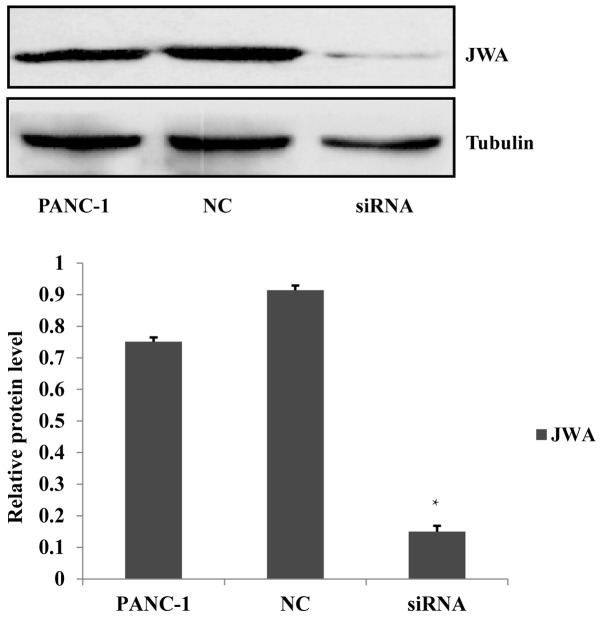
Effects of JWA siRNA. To investigate whether JWA was involved in PANC-1 cells, a specific JWA siRNA cell culture model was developed. The specific siRNA and the NC siRNA were transiently transfected into PANC-1 cells, respectively. Western blot analysis showed that the specific siRNA significantly suppressed the expression of JWA (*P<0.05) (siRNA group) as compared with the PANC-1 blank group and the NC. Error bars represent the standard deviation. siRNA, small interfering RNA; NC, negative control; PANC-1, human pancreatic cancer cells.